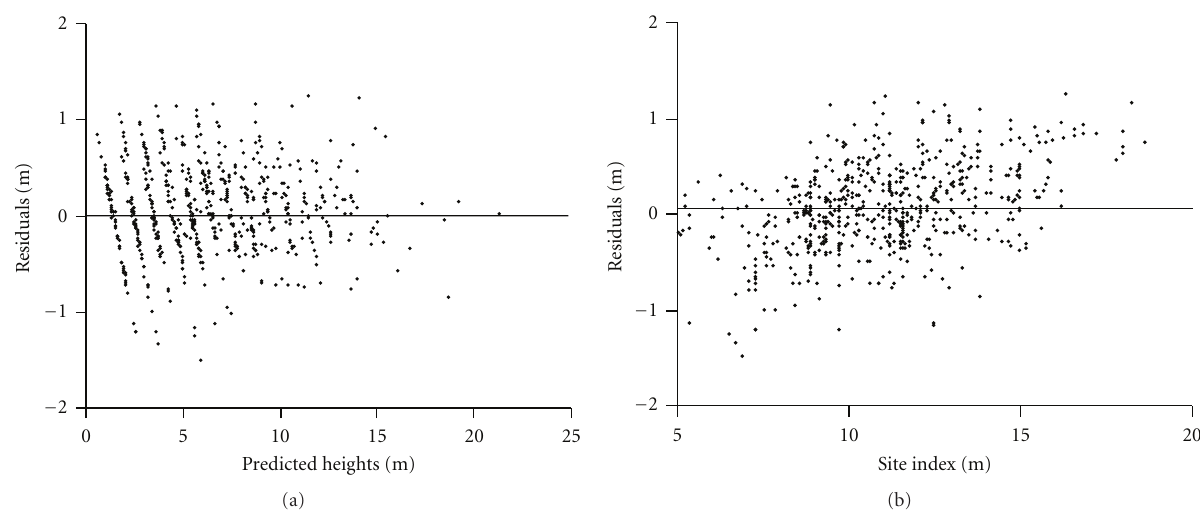
Figure 6: Residuals versus predicted heights (a) and site index at reference age of 30 years (b) for model M6 (the GADA formulation of the Lundqvist-Korf base equation that considers two site-specific parameters) fitted with a second-order continuous-time autoregressive error structure (CAR(2)).